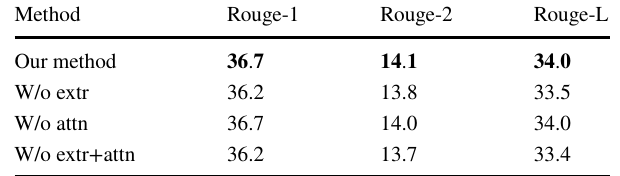
Best results are in